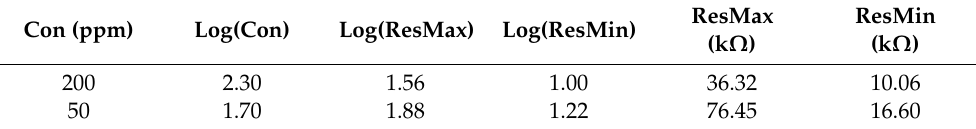
Table 3. Logarithmic values of concentrations and resistance values of